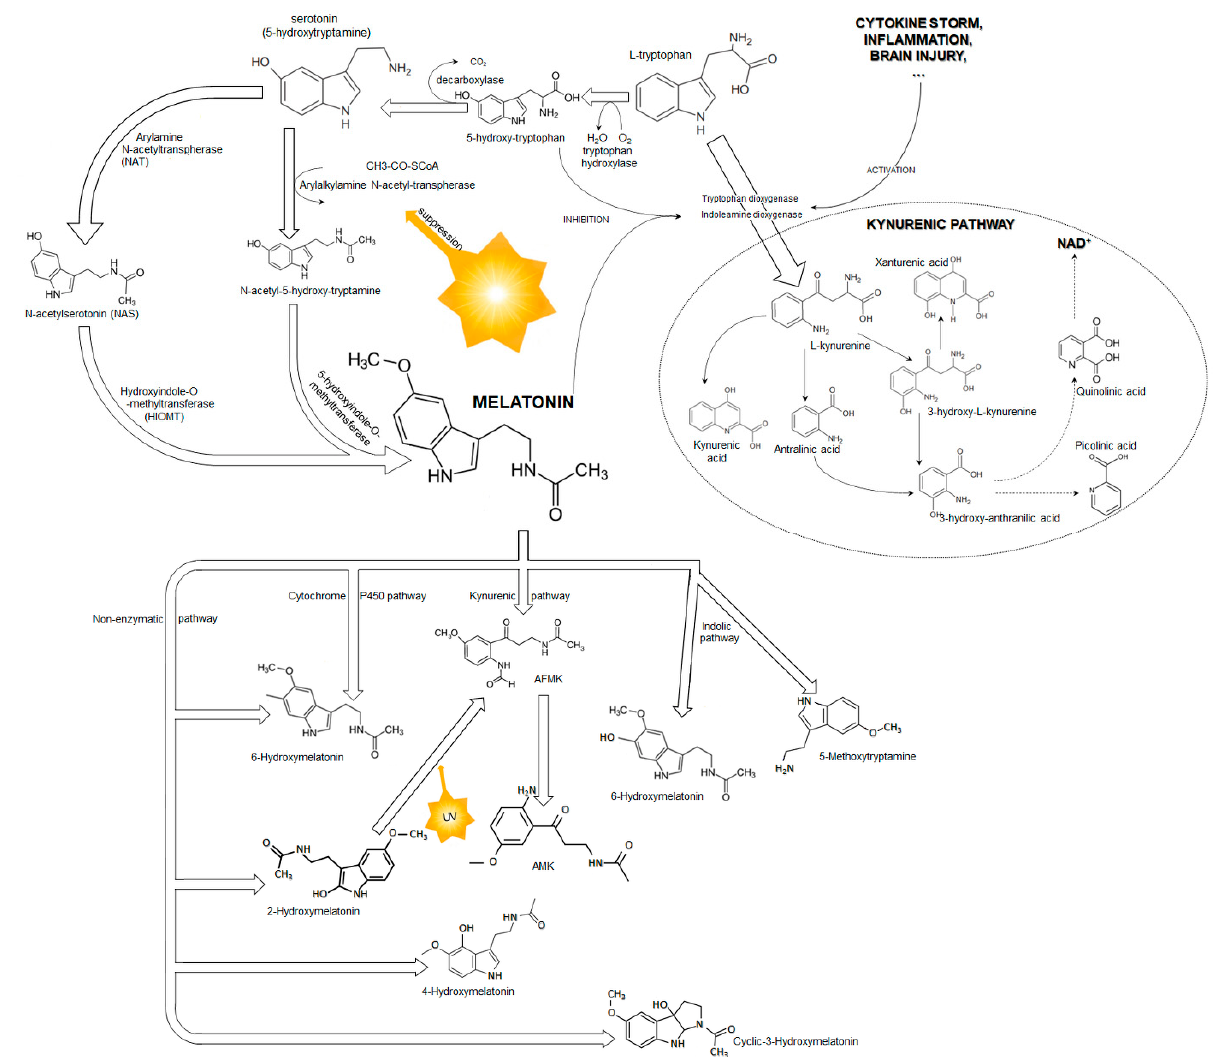
Figure 2. A scheme of melatonin biosynthesis from tryptophan and melatonin metabolism. Serotonin and NAS are produced endogenously in the pineal gland as well as in peripheral organs such as the liver and the epidermal, dermal, and adnexal compartments of human skin. Both were found in human serum, and serotonin levels were 2.6 times higher than those of NAS in the epidermis and 121 times higher in the serum [26]. It was documented that serum serotonin concentrations did not depend on age or gender, whereas NAS concentrations were slightly higher in females than in males [27]. Interestingly, clinical observations showed dramatically lower serum NAS concentration in children with attention disorders, and changes in its concentrations corresponded to the sleep cycle